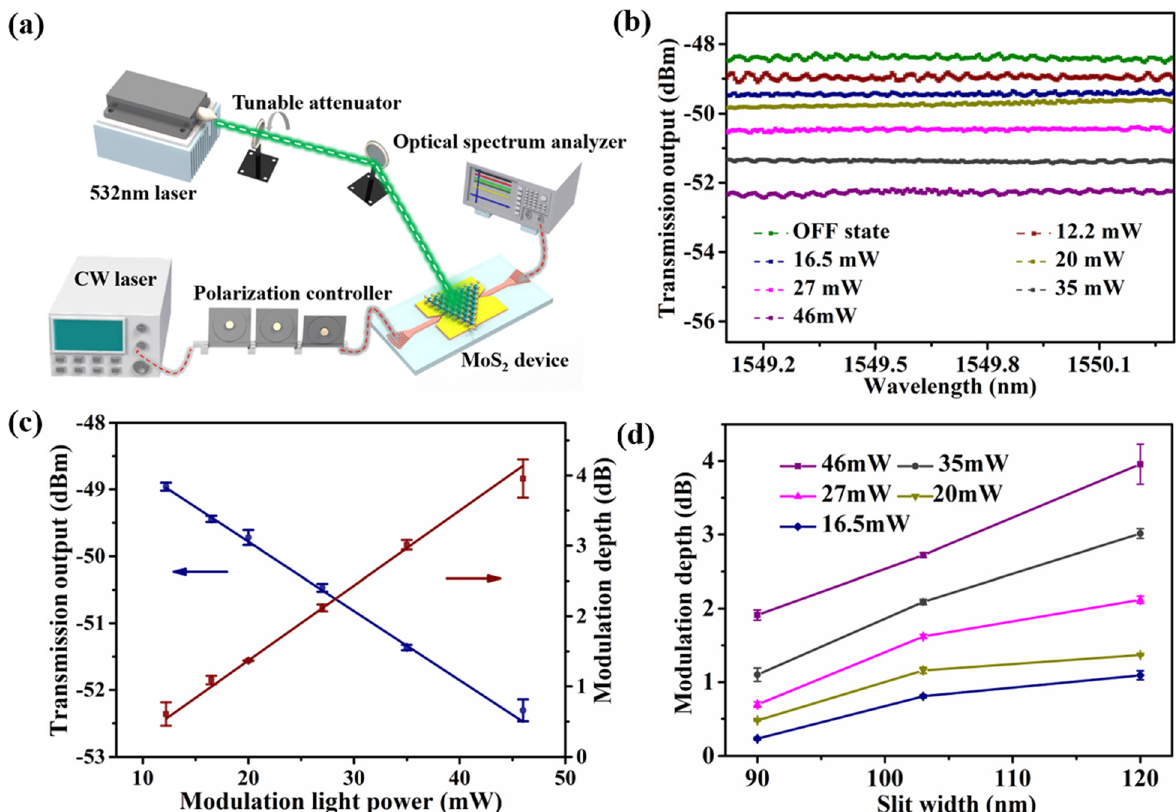
Figure 3: MoS 2 -plasmonic nanoslit device all-optical modulation. (a) All-optical modulation test system. (b) Change in signal light output with modulation light power. (c) Transmission output ( T (dBm) = 10 × log10( P out /1 mW)) and modulation depth of the signal light. (d) Modulation depth as a function of slit width; the slit widths are 90, 110, and 120